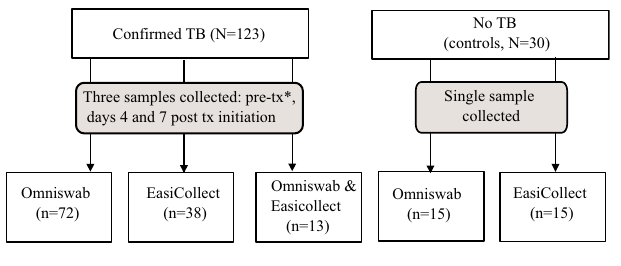
Figure 1. Flowchart of participant enrollment and oral swab sample collection method.